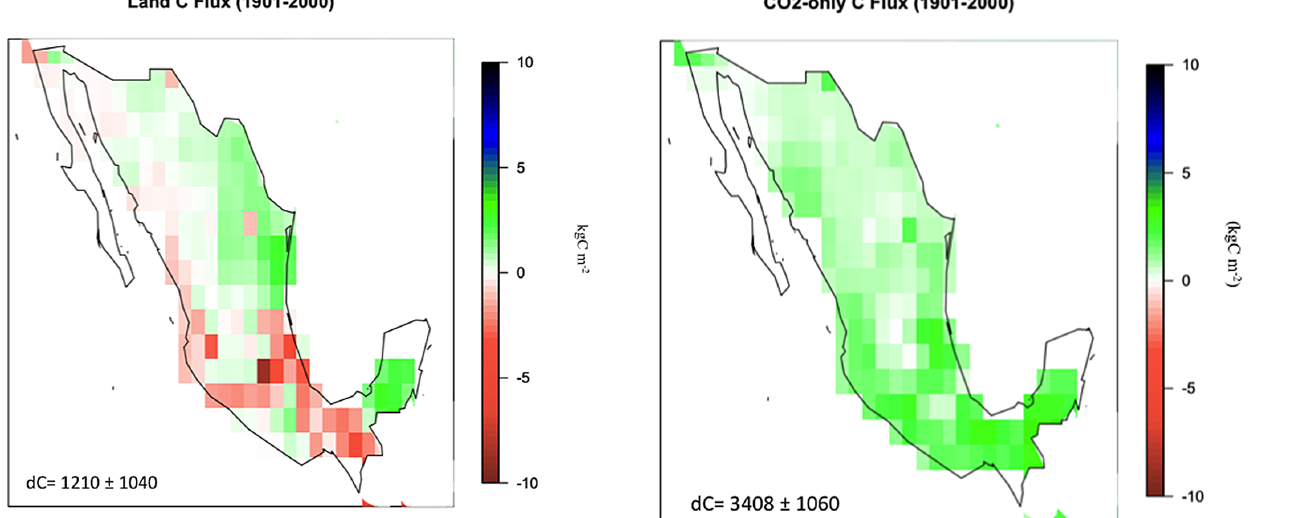
Figure 7. Change in total stored C by the effect of CO 2 only over the period 1901–2000 (kgCm − 2 ) . A positive sign indicates C gain. dC is total change in stored C